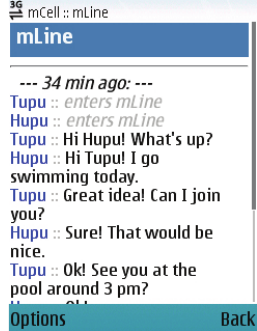
Figure 4: Screenshot of an mLine